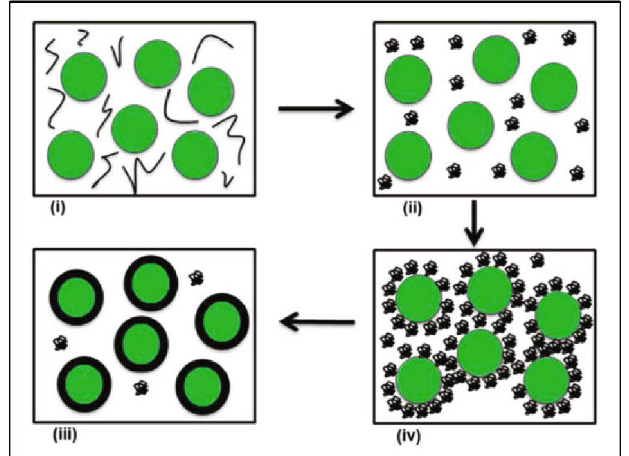
Figure 25: Example of complex coacervation involving (i) emulsi fi cation of oil in an aqueous solution containing two di ff erent polymers, (ii) initial coacervation of polymers after lowering the solution pH below the isoelectric point of protein, (iii) deposition of the polymers on the surface of the oil, and (iv) wall hardening by addition of a cross-linking agent.